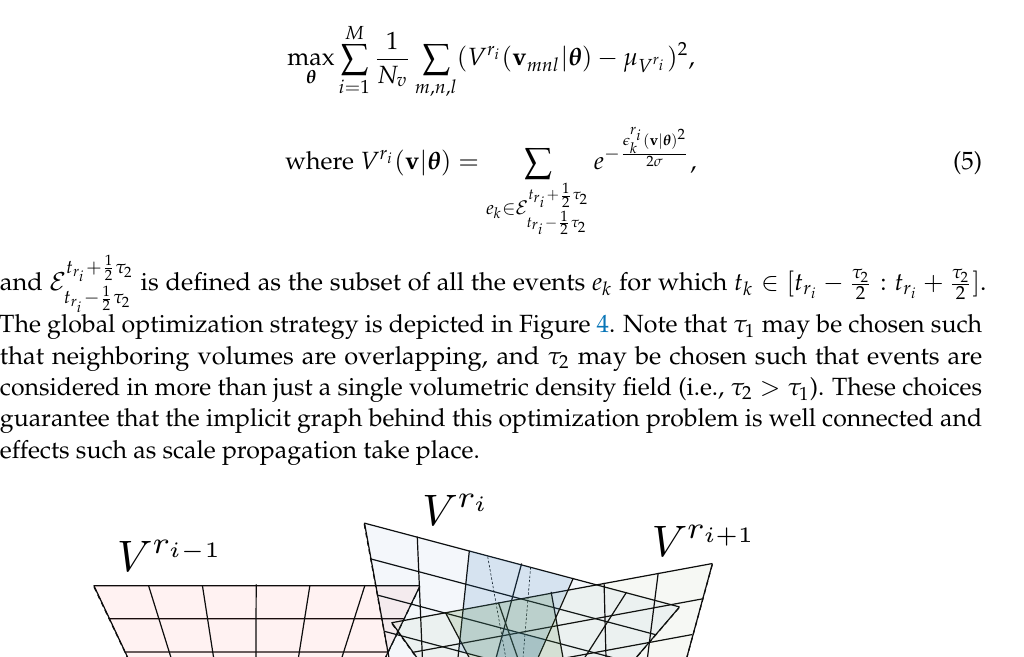
1 + 1 τ 2 : t r τ 2 ] associated with each reference volume 2 2 i − i